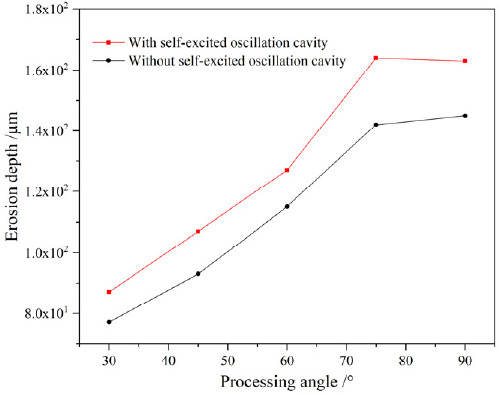
Figure 17. Erosion depth influence curve under different angles.